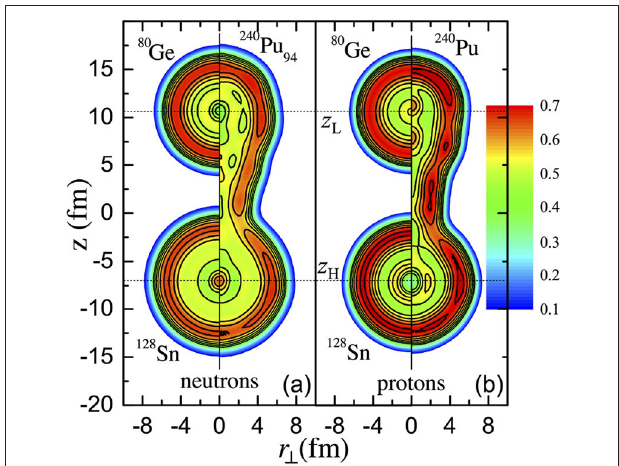
FIGURE 2 | Right of each panel: neutron (a) and proton (b) localization functions in a deformed configuration on the fission path of 240 Pu. Left of each panel: NLFs of the localized prefragments, 80 Ge and 128 Sn, as indicated. Vertical lines are symmetry axes. Maximum extensions of the NLFs along the radial coordinate r ( z ) are marked with horizontal dotted lines: z ⊥ z z H . The figure is adapted from Sadhukhan et al. [92]. =